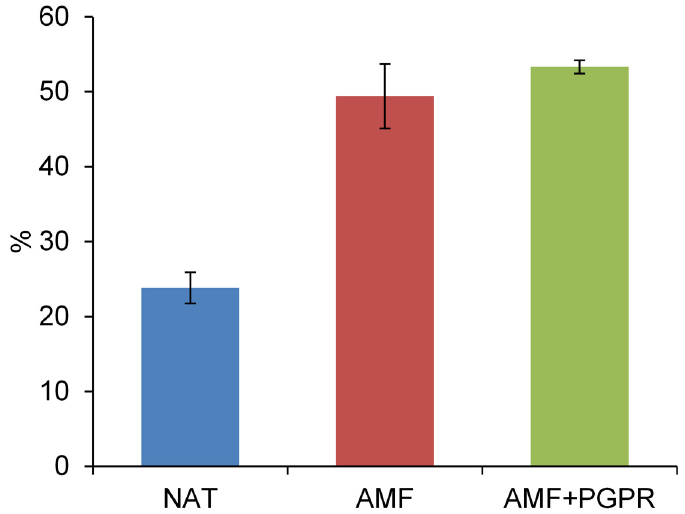
Fig 1. Root colonization by AMF in roots of durum wheat. Wheat with natural arbuscular mycorrhizal inoculum (NAT), inoculated with AM fungi spores (AMF), or inoculated with both AMF and plant growth — promoting rhizobacteria (AMF+PGPR). Data are means ± S.E. (n =